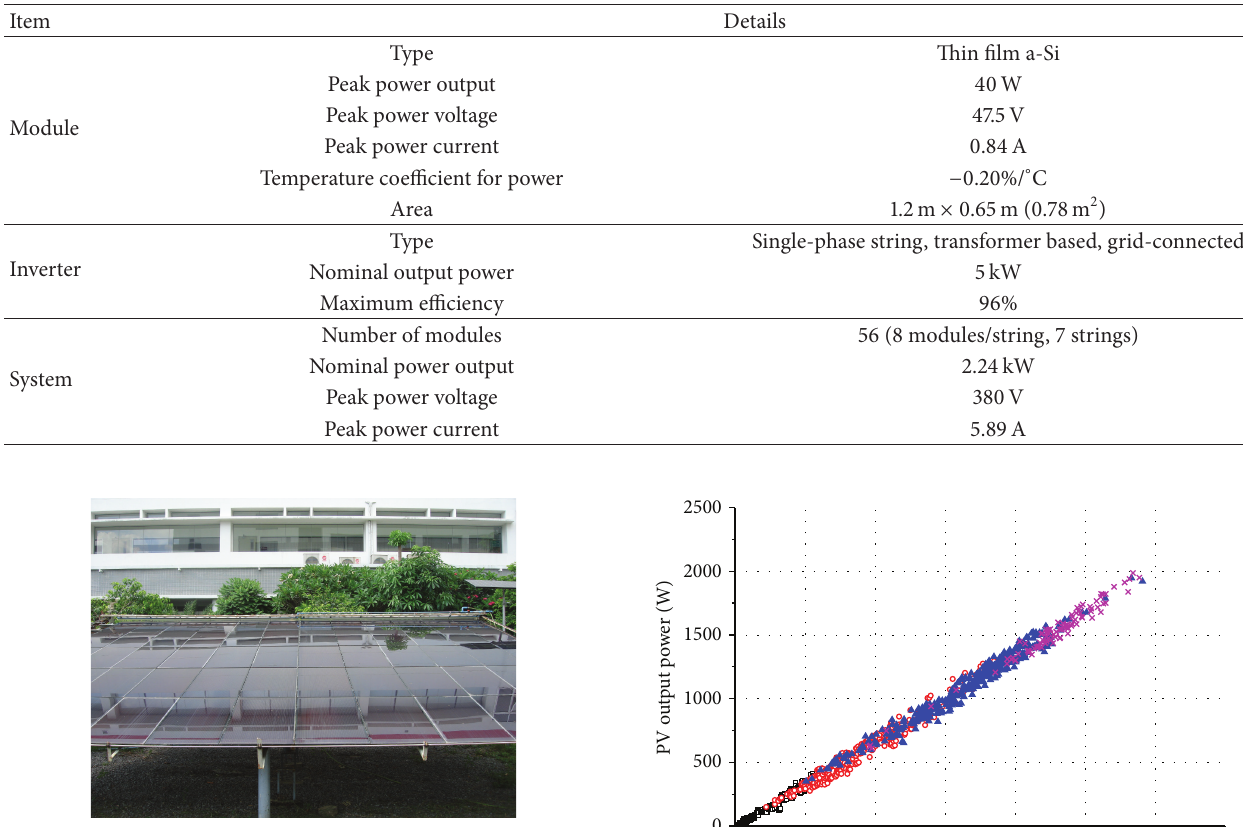
Figure 1: PV test site at NSTDA, Thailand.